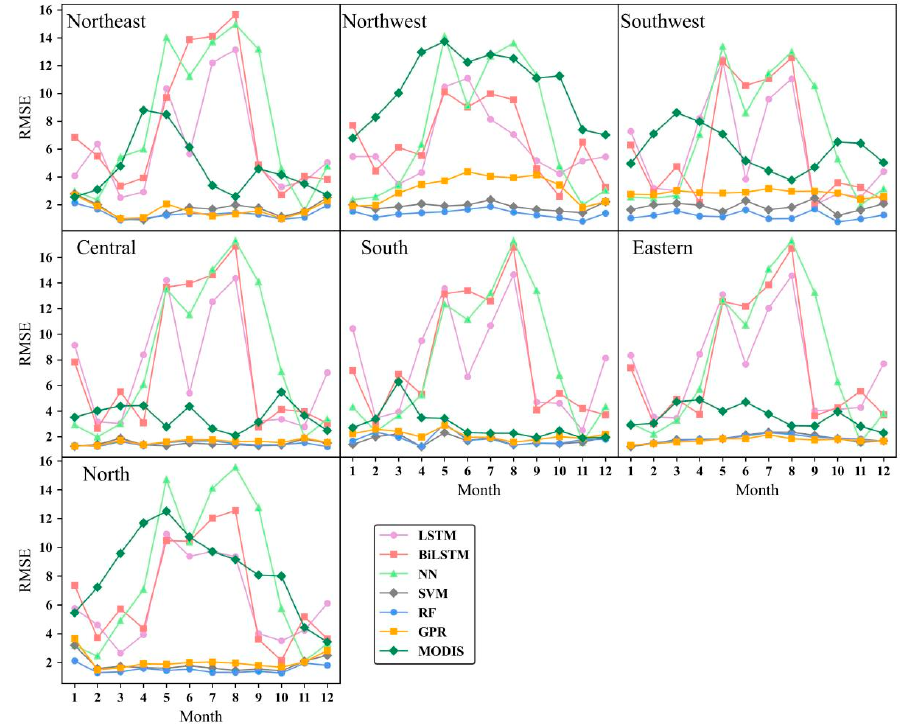
Figure 15. RMSE values by month for different regions.